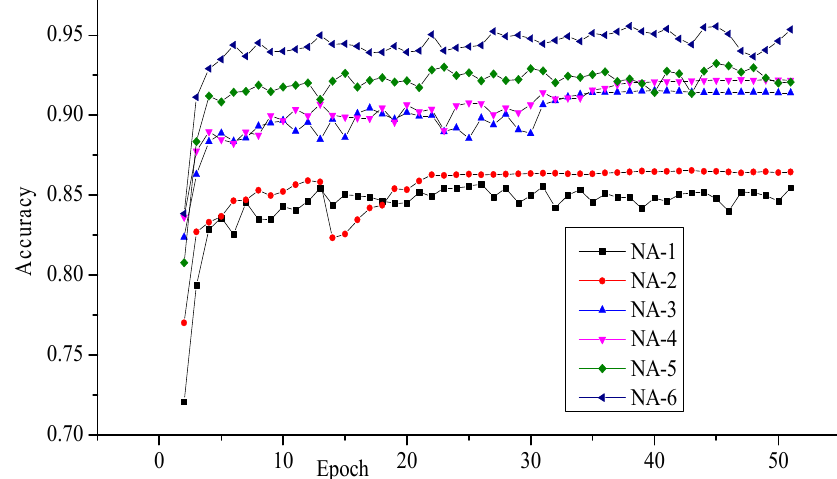
Figure 3. In this figure, we draw the recognition accuracy obtained with different network architectures on ISIDCHAR database at each epoch. The Adam optimizer was used. Table 2. In this table, we report the results in term of maximum, minimum, mean, and standard deviation recognition accuracy obtained with different network architectures on ISIDCHAR when the system trained for 50 epochs with the Adam optimizer. The best scores are in bold.